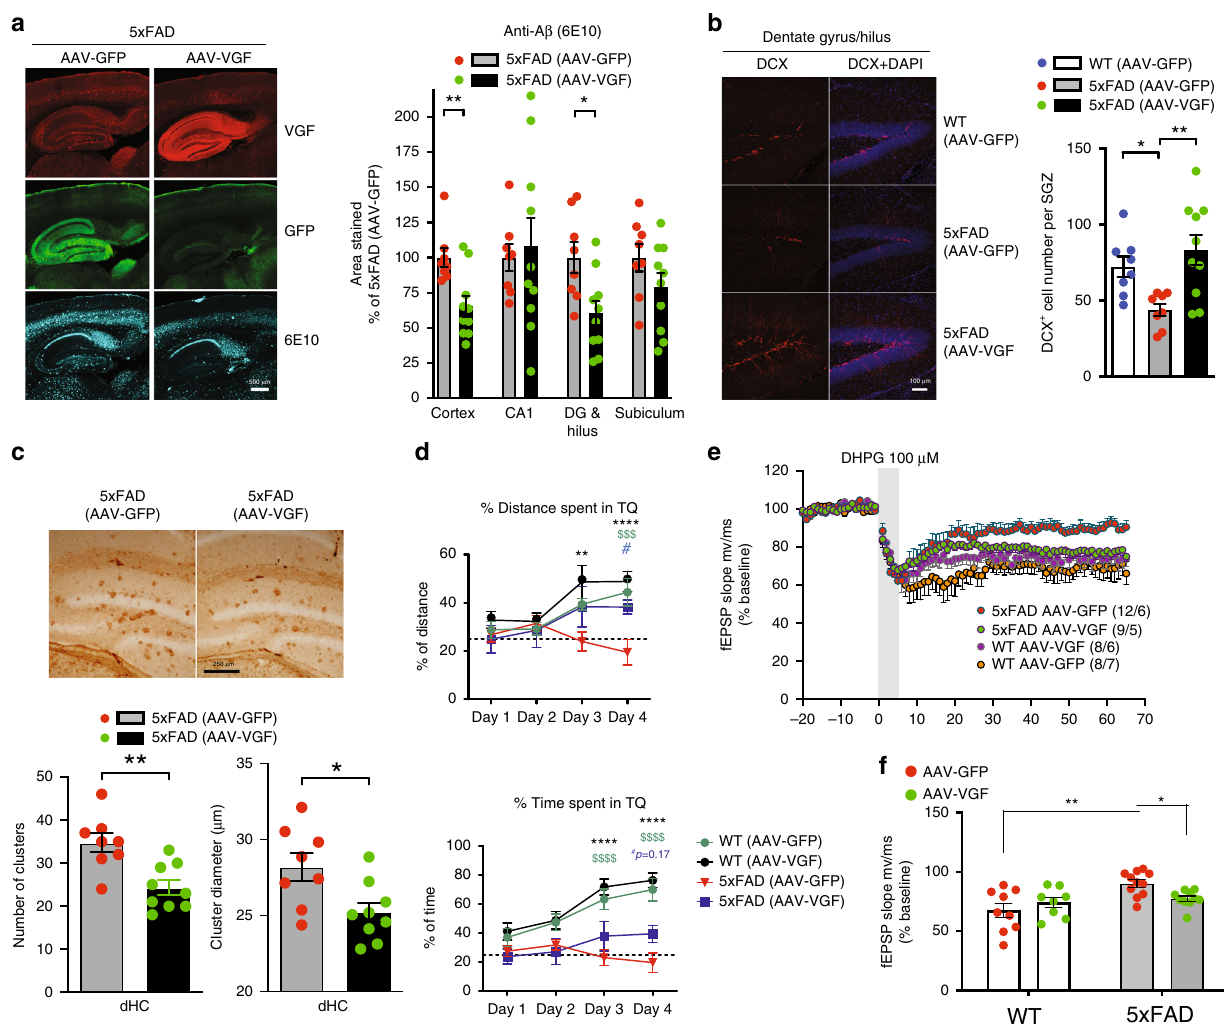
Fig. 6 Characterization of AD pathophysiology in 5xFAD mice with and without AAV5-VGF-driven overexpression of VGF. a Immunohistochemical staining of A β amyloid plaques and VGF in the 5xFAD mouse brain 4 months after AAV5-VGF or AAV5-GFP infusion into the dorsal hippocampus. Left panel, red: VGF, cyan: A β , green: GFP; right panel, quanti fi cation of percent area of A β amyloid plaque in different brain areas. N = 4, 5 male mice per group. Data are presented as mean percentage± SEM (of the control group, two-sided Student ’ s t test. ** p = 0.004, * p = 0.0121. b Doublecortin staining (DCX) in the dentate/hilus area. Upper panel, red: DCX, blue: DAPI; lower panel, average number of DCX-positive cells per subgranular zone. N = 4 – 5 male mice per group. Data were analyzed by one-way ANOVA with Newman – Keuls post hoc analysis, F (2, 23) = 6.574, p = 0.0055, n = 4, 4, 5 male mice per group, 2 slices analyzed per animal. * p < 0.05, ** p < 0.01. c Reduced staining of phosphor-Tau and reduction of dystrophic neurite cluster number and diameter in 5xFAD brains with AAV5-VGF overexpression. Upper panel, phosphor-Tau staining; lower panel, quanti fi cation results of dystrophic neurite cluster number and diameter in the dorsal hippocampus. N = 4, 5 male mice per group. Data were analyzed by two-sided Student ’ s t test. * p = 0.0162, ** p = 0.0021. d Barnes maze test. Mice were trained daily and on Day 4 WT mice learned the target quarter (TQ) of the hiding zone, as revealed by increased distance traveled in the TQ (left panel), and increased time spent in the TQ (right panel). 5xFAD mice with AAV5-GFP showed impaired spatial learning on day 4, while in 5xFAD with AAV5-VGF overexpression, memory performance was signi fi cantly rescued. N = 12, 9, 10, 7 mice (male + female) per group. Data were analyzed by two-way repeated-measures ANOVA. % of distance spent in TQ: Days ( F (3,102) = 5.000, p < 0.01) and Groups ( F (3,34) = 5.997, p < 0.01), and Days × Groups interaction ( F = 2.371, p < 0.05). % time spent in TQ: Days ( F = 11.39, p < 0.0001) and Groups ( F = 13.62, (9,102) (3,102) (3,34) p < 0.0001), and Days × Groups interaction ( F = 3.824, p < 0.001). Tukey ’ s post hoc test. # p < 0.05, ** p < 0.01, $$$ p < 0.001, **** ,$$$$ p < 0.0001. (9,102) e Impaired DHPG-mediated long-term depression (LTD) in 5xFAD mice is partially restored by AAV-VGF expression in the dHc. N: WT (AAV-GFP) = 8 slices from seven mice; 5xFAD (AAV-GFP) = 12 slices from six mice; WT (AAV-VGF) = 8 slices from six mice; 5xFAD (AAV-VGF) = 9 slices from fi ve mice. f Summary graph of data from e indicating the average fEPSP slope [mV/ms (% of baseline)] during the last 5 min of recording. Data were analyzed by two-way ANOVA. Slope mV/ms (% of baseline): Genotype ( F (1,34) = 9.396, p < 0.001) and Groups (AAV-VGF and AAV-GFP) ( F (1,34) = 0.3282, p = 0.5705) and Genotype× Groups interaction ( F (1,34) = 5.045, p < 0.01). Newman – Keuls post hoc test. * p < 0.01, ** p < 0.001. All data in b – f are presented as mean ± (DE FDR = 3.4e − 15) and gene (DE FDR = 5.0e − 4) expression power in distinguishing between AD cases and controls. We data in cases versus controls, and it was the only gene identi fi ed as replicated VGF as a KD in an independent dataset and in two KD across all three Bayesian causal networks constructed. Fur- additional brain regions, demonstrated genetic support with the ther, VGF ranked as the top KD having the most explanatory association of AD PRS to the levels of expression of VGF , and